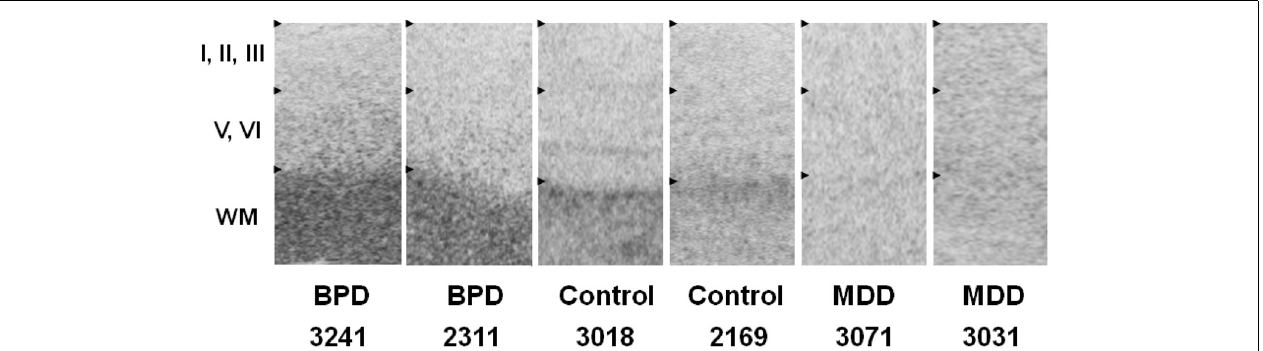
FIGURE 2 | In situ hybridization images of GPR37 mRNA in representative BPD, MDD and control subjects. GPR37 mRNA is preferentially expressed in subcortical white matter. Among six layers of cortical gray matter, GPR37 expression in deeper layers (V–VI) is relatively higher than in superficial layer